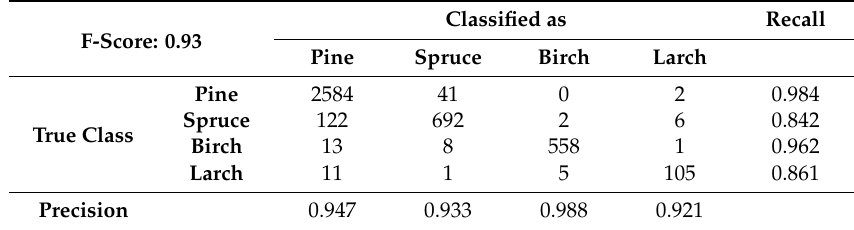
Table 15. Confusion matrix of classification using RandomForest with a feature-selected data set selected from all features. F-score presents the mean F-score for all species.